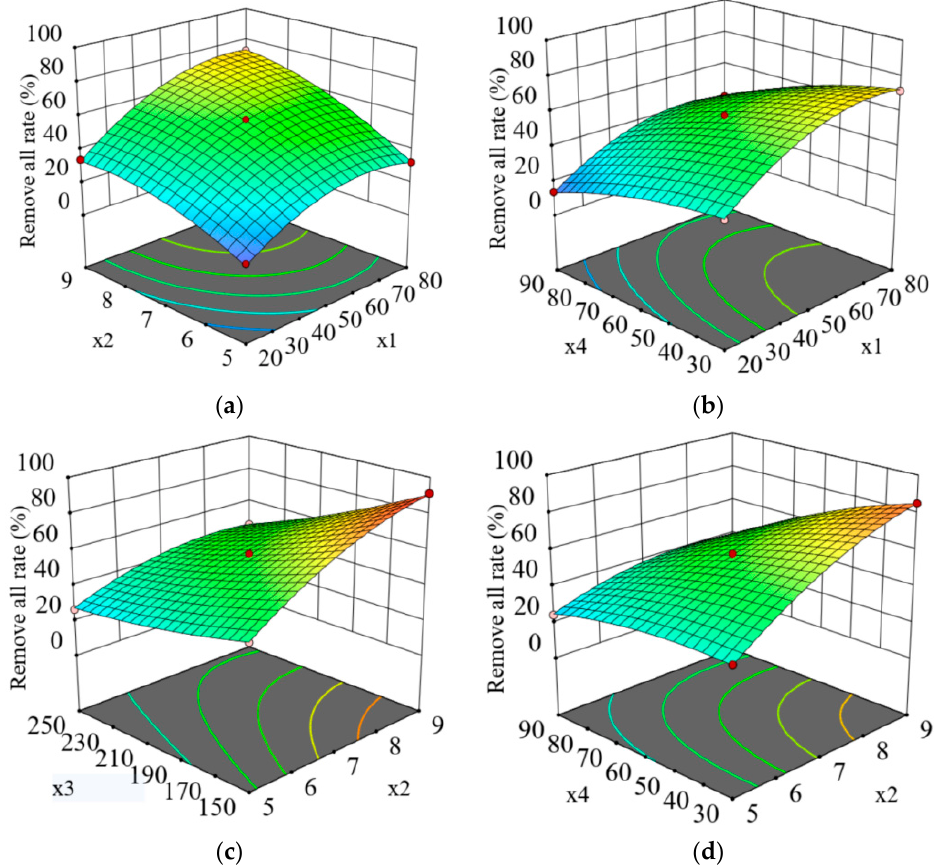
Figure 8. The interaction of factors affected the response surface of the removal rate: ( a ) x 3 and x 4 were 200 mm and 60 mm, respectively, the relationship between the removal rate and x 1 x 2 ; ( b ) x 2 and x 3 were 7 m·s − 1 and 200 mm, respectively, the relationship between the removal rate and x 1 x 4 ; ( c ) x 1 and x 4 were 50 mm and 60 mm, respectively, the relationship between the removal rate and x 2 x 3 ; ( d ) x 1 and x 3 were 50 mm and 200 mm, respectively, the relationship between the removal rate and x 2 x 4 .